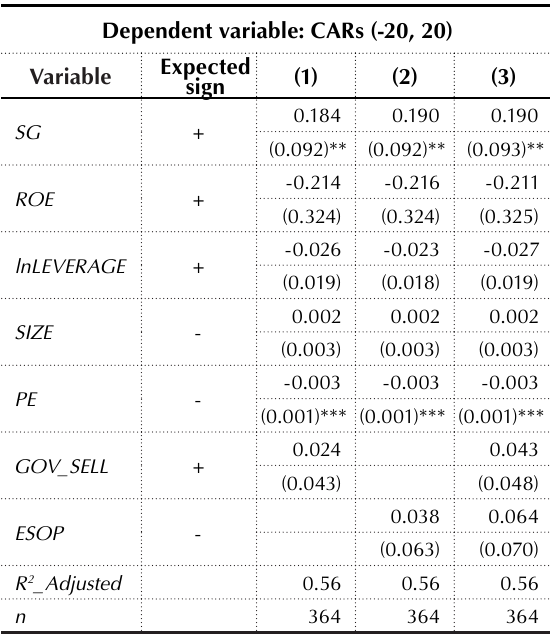
Table 5. Estimated results of multi-factor model (equation